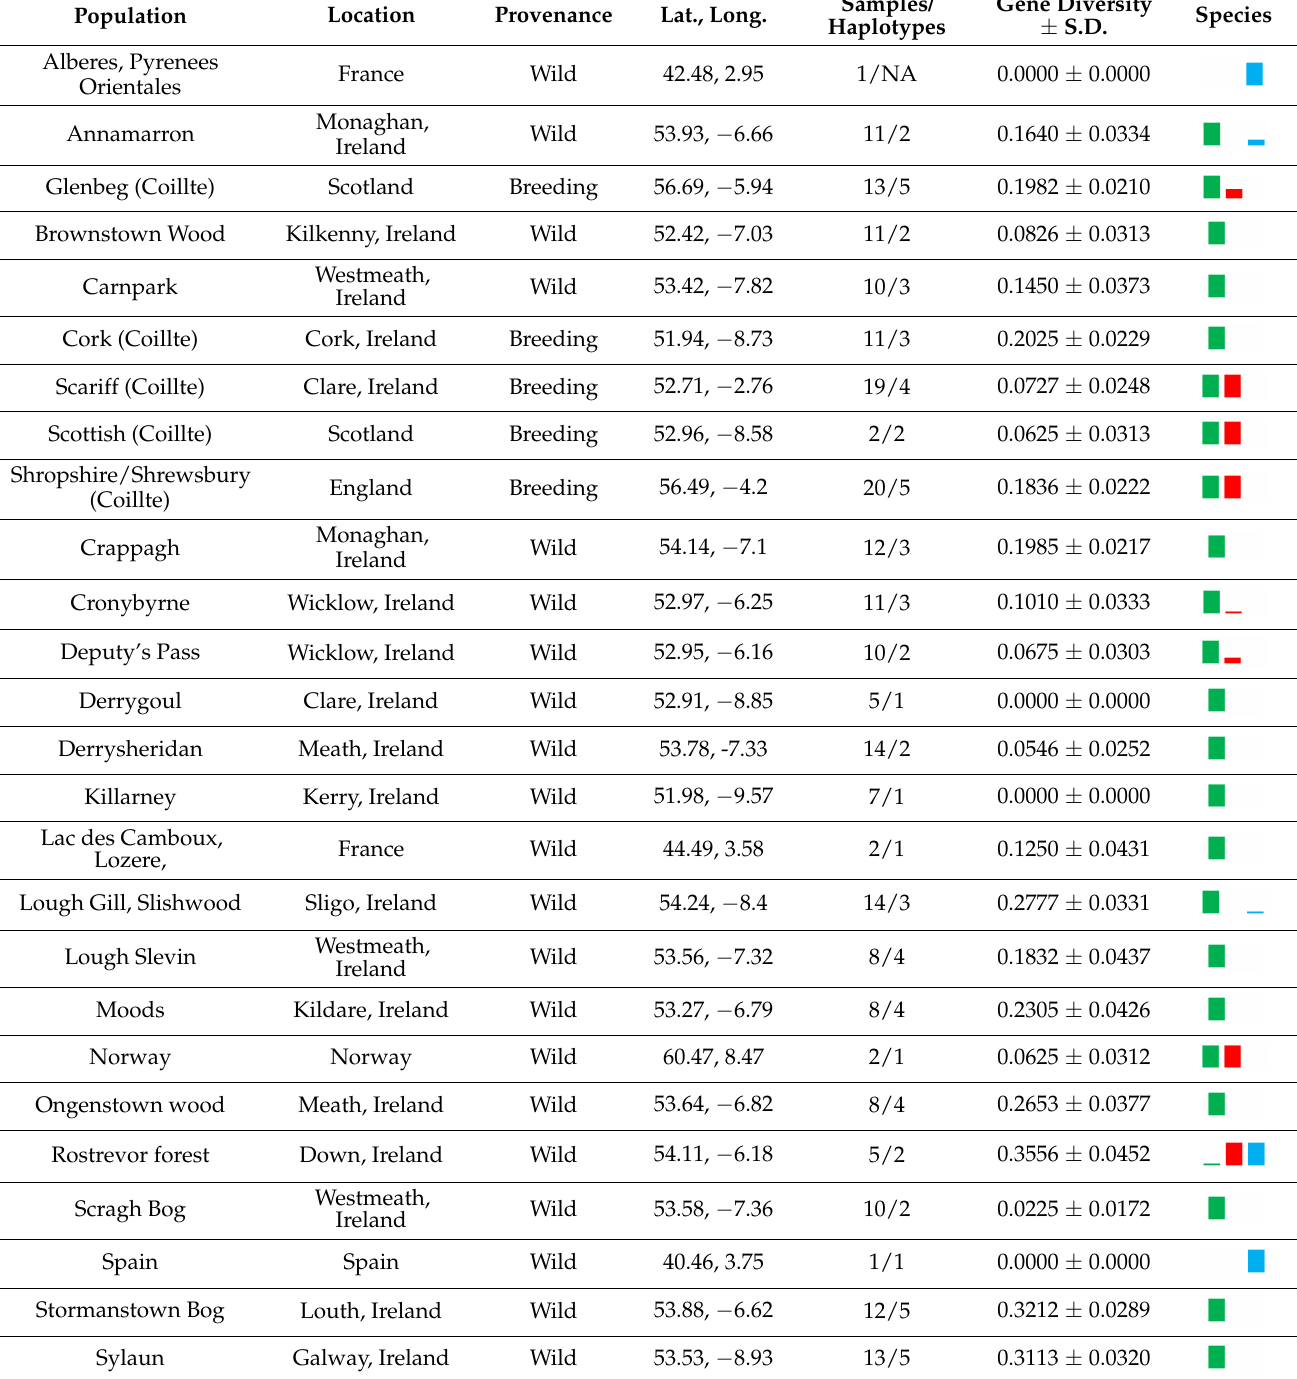
Table 1. Details of Betula spp. sampling locations. Bars in the species column correspond to the frequency of B. pubescens (green), B. pendula (red), and putative hybrid (blue) individuals in each sampling population.